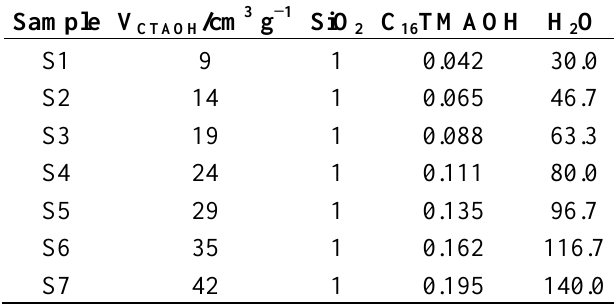
Table 1. Volume of CTAOH solution V and molar composition of synthesis mixtures CTAOH for pseudomorphic transformation of 1 g silica gel LiChrospher ® Si